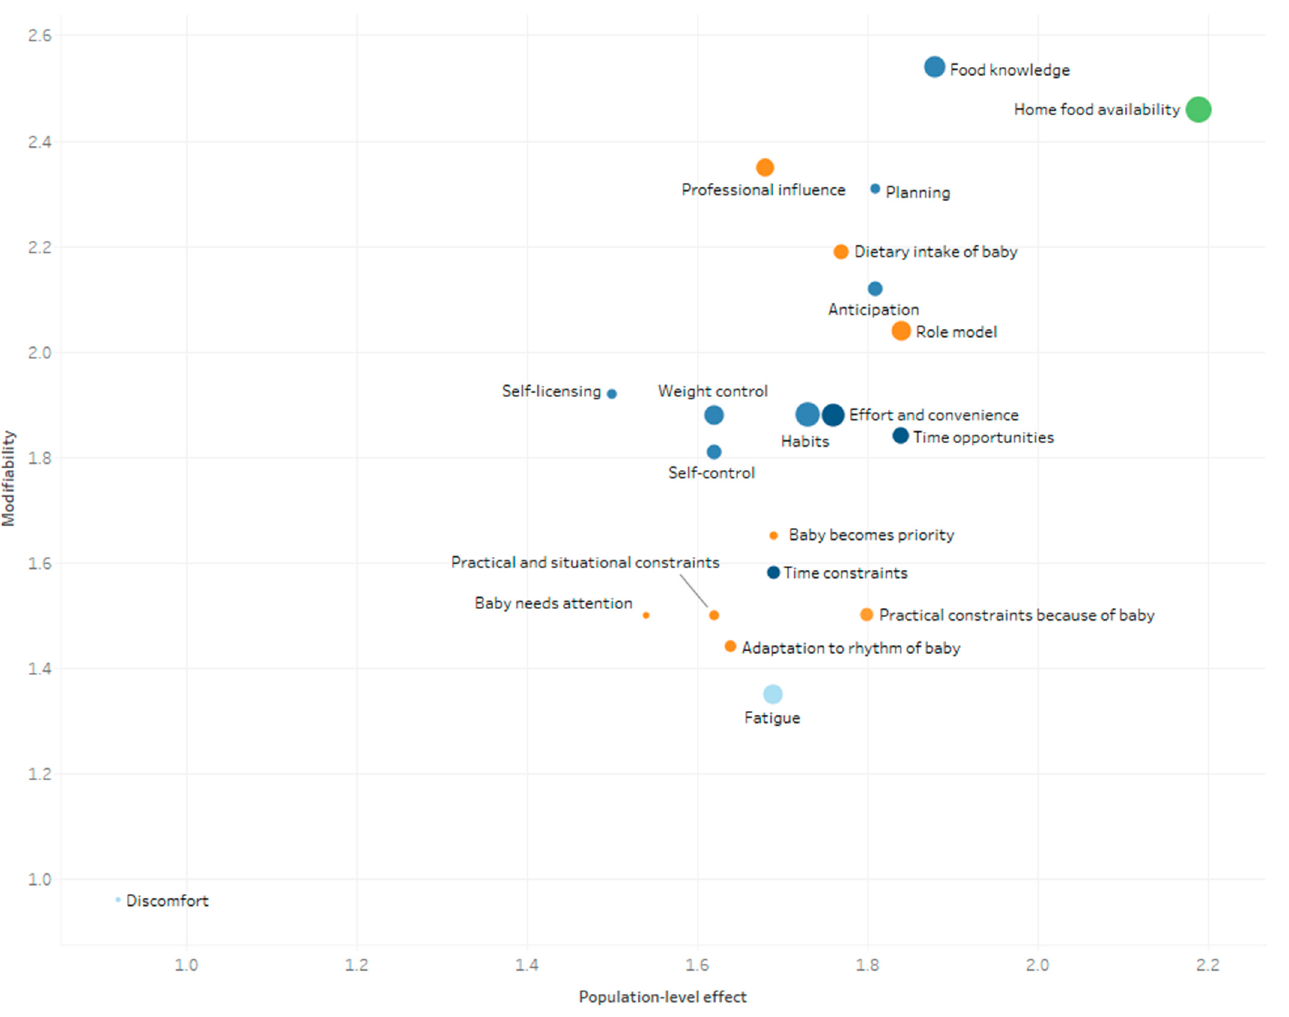
Figure 7. Expert ratings on modifiability, relationship strength, and population-level effect of men’s determinants of changes in eating behavior within the first year postpartum.